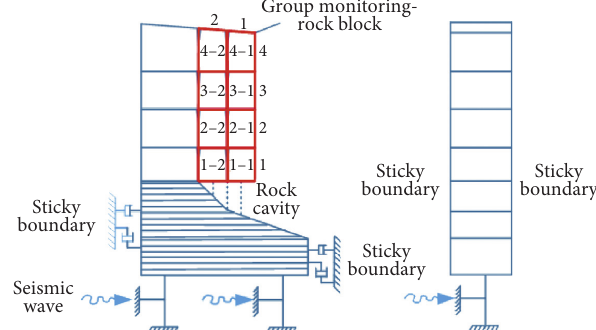
Figure 6: Boundary conditions of slope dynamic